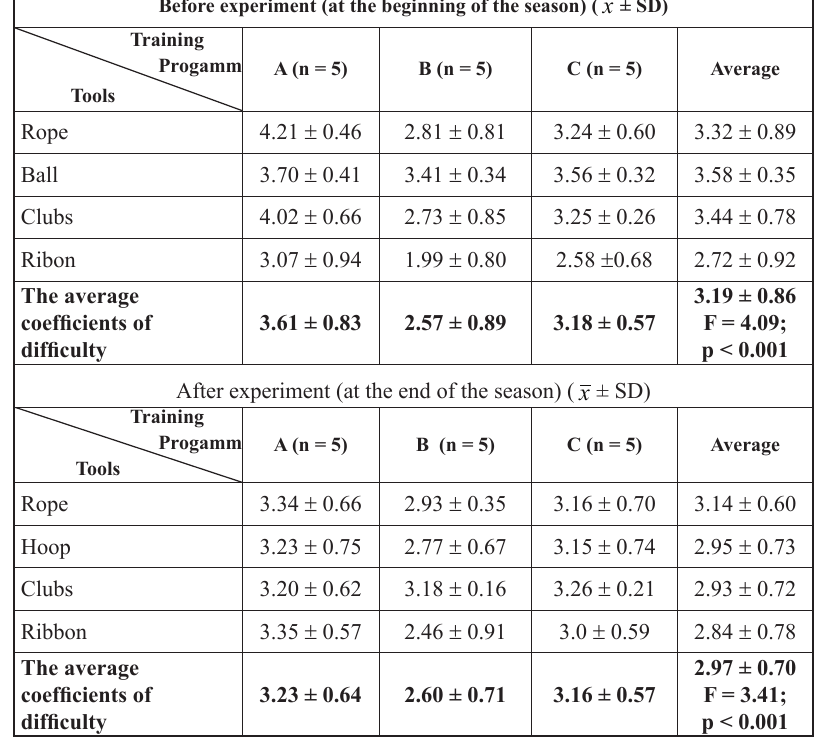
Table 4. Body movement technique coefficients of difficulty with different tools in different rhythmic gymnastics training programs for 13–14-year-old